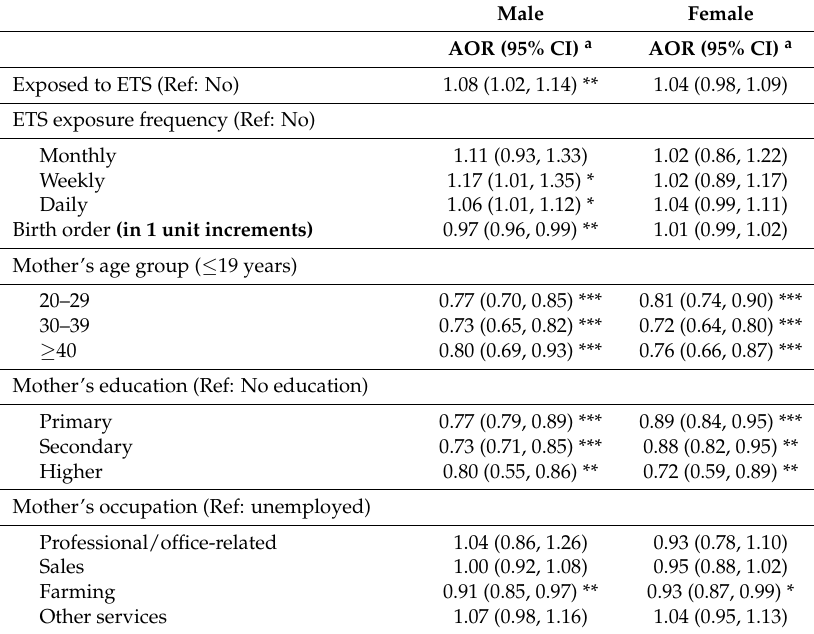
Table 3. Adjusted odds ratios of the logistic regression analyses for low birthweight in Africa, stratified by child’s